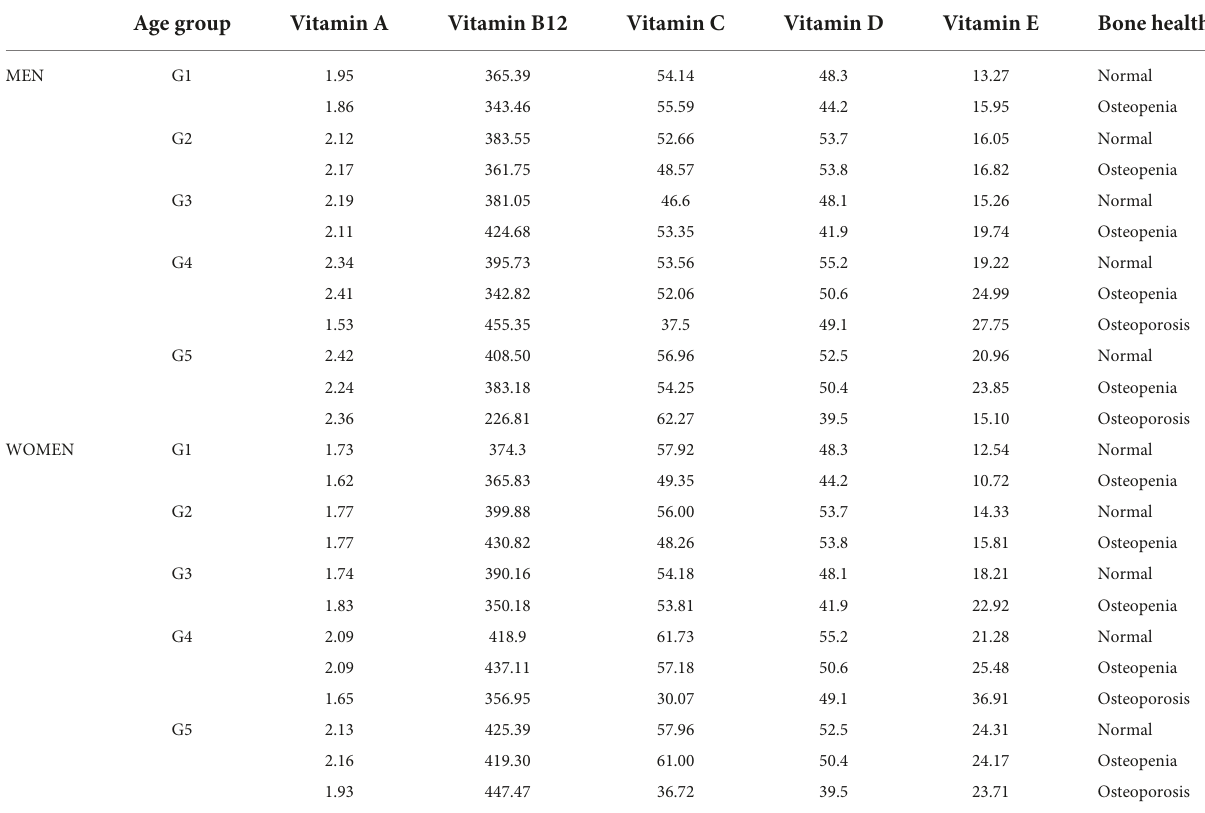
TABLE 2A Mean levels of vitamin A ( µ mol/L), B12 (pmol/L), C ( µ mol/L), D (nmol/L), and E ( µ mol/L) concentrations stratified by age group and osteoporosis status in women. Age group Vitamin A Vitamin B12 Vitamin C Vitamin D Vitamin E Bone